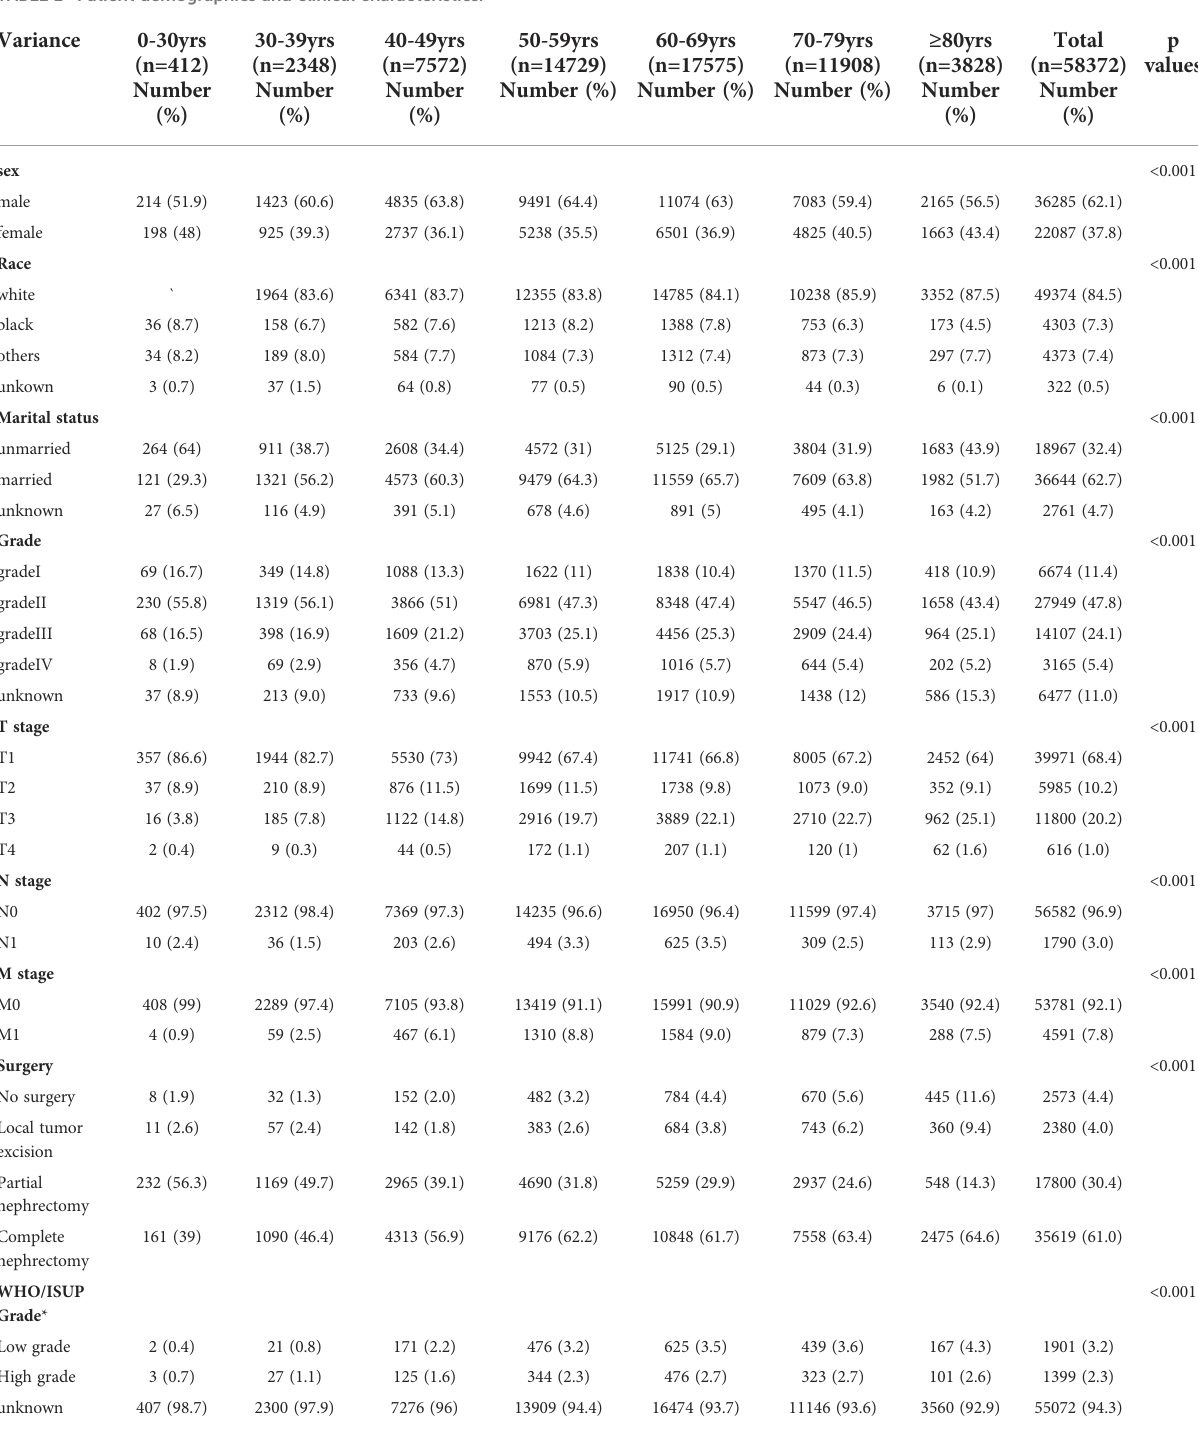
TABLE 1 Patient demographics and clinical